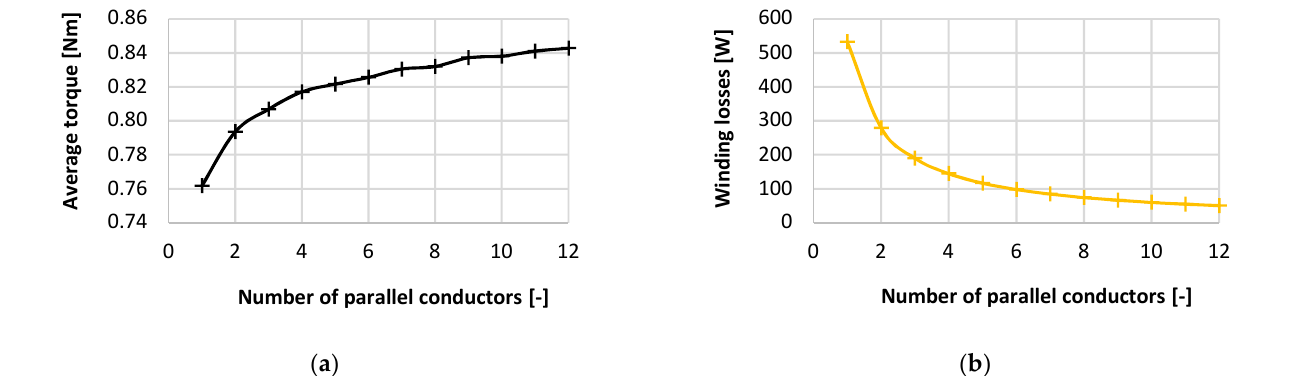
Figure 12. Results of the electromagnetic analysis for different numbers of parallel conductors: ( a ) average torque; ( b ) winding losses.